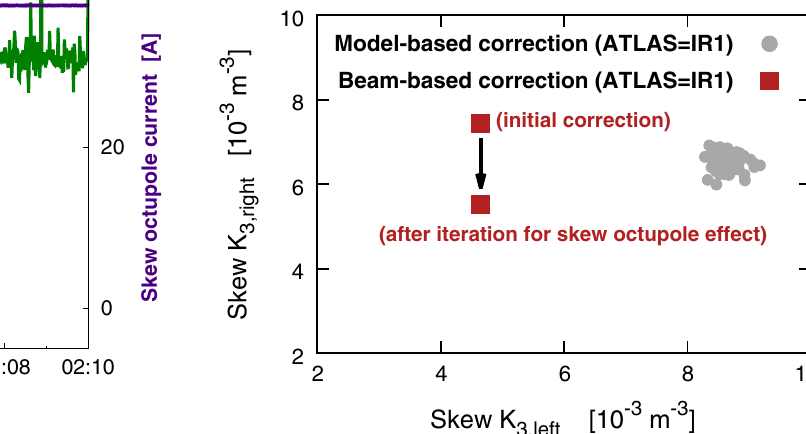
FIG. 21. Change to Q y of Beam 2 upon application of skew- octupole correction for feed-down to j C − j , with a 150 μ rad vertical crossing angle in IR1 (ATLAS).